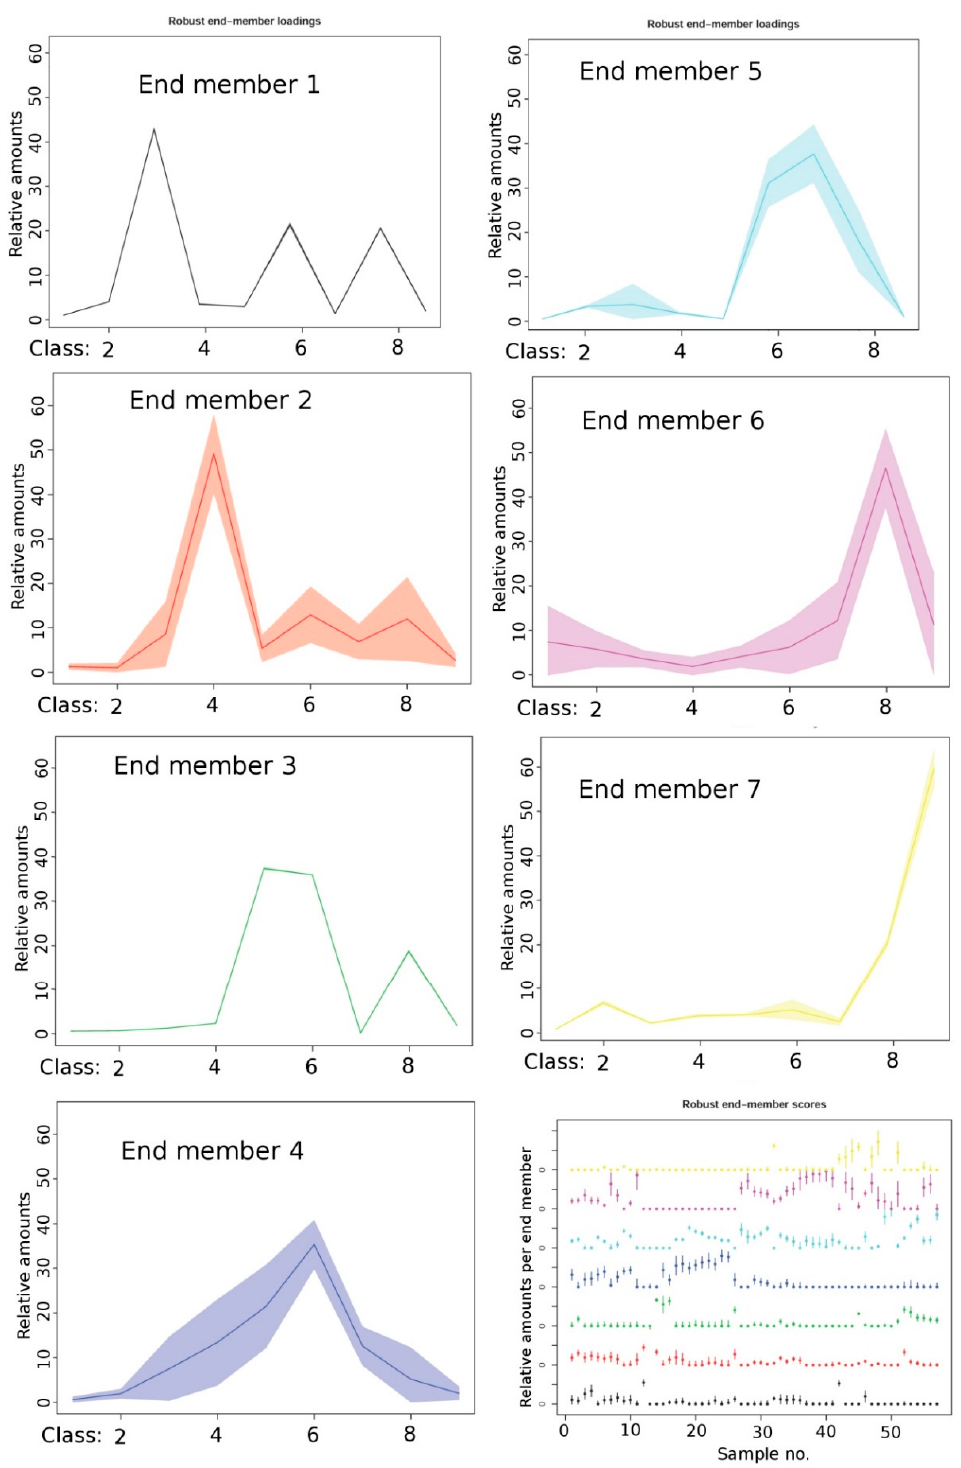
Figure 9. Particle size distributions of 7 end-members modeled with EMMAgeo and charts showing the respective end-member scores (relative amounts from 0–1) for each individual sample. Grain-size classes range from 1 (fine clay) to 9 (coarse sand). The chart to the bottom right, showing the robust end-member scores for each sample, displays end-member 1 at the bottom and the subsequent end-members upwards, until end-member 7 at the top. For a detailed list of the samples that were used in calculation of the statistics, including respective individual sample numbers, see Appendix F.